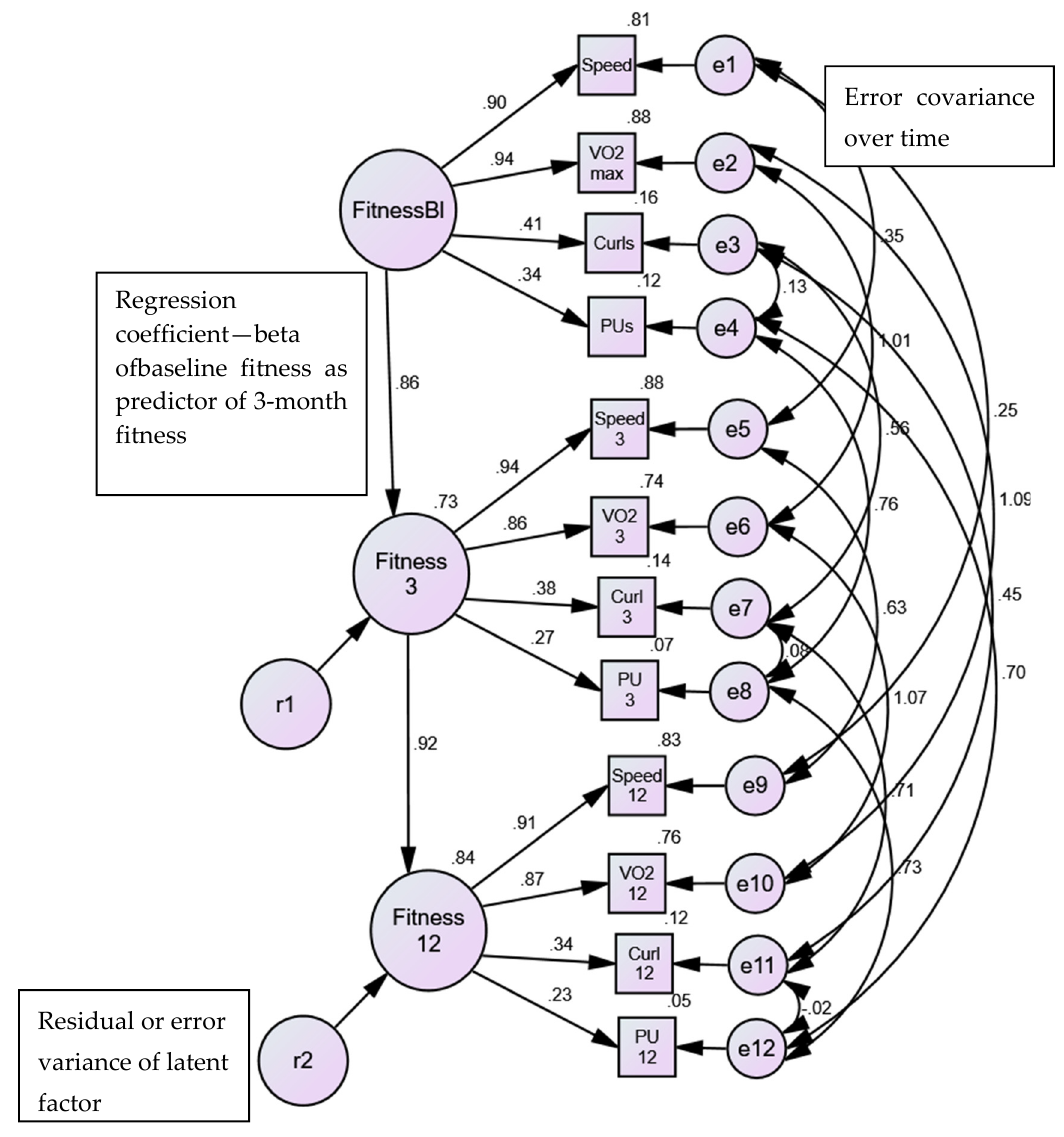
Figure 3. Sex and time invariance. FitnessB1 = baseline; Fitness3 = 3-months; Fitness12 = 12-months Speed = treadmill speed; VO 2 max = age-sex percentile; Curls = Curl-ups; PU = Push-ups; e# and r# = error terms. Squares are measured variables; circles are latent